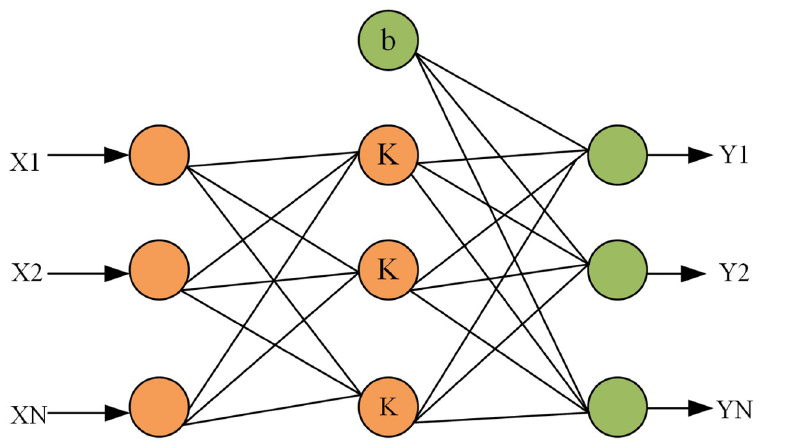
Fig 4. SVM nonlinear